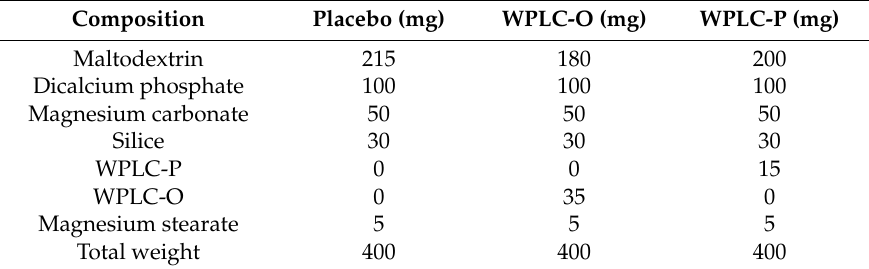
Table 4. Qualitative and quantitative formula of test products (per